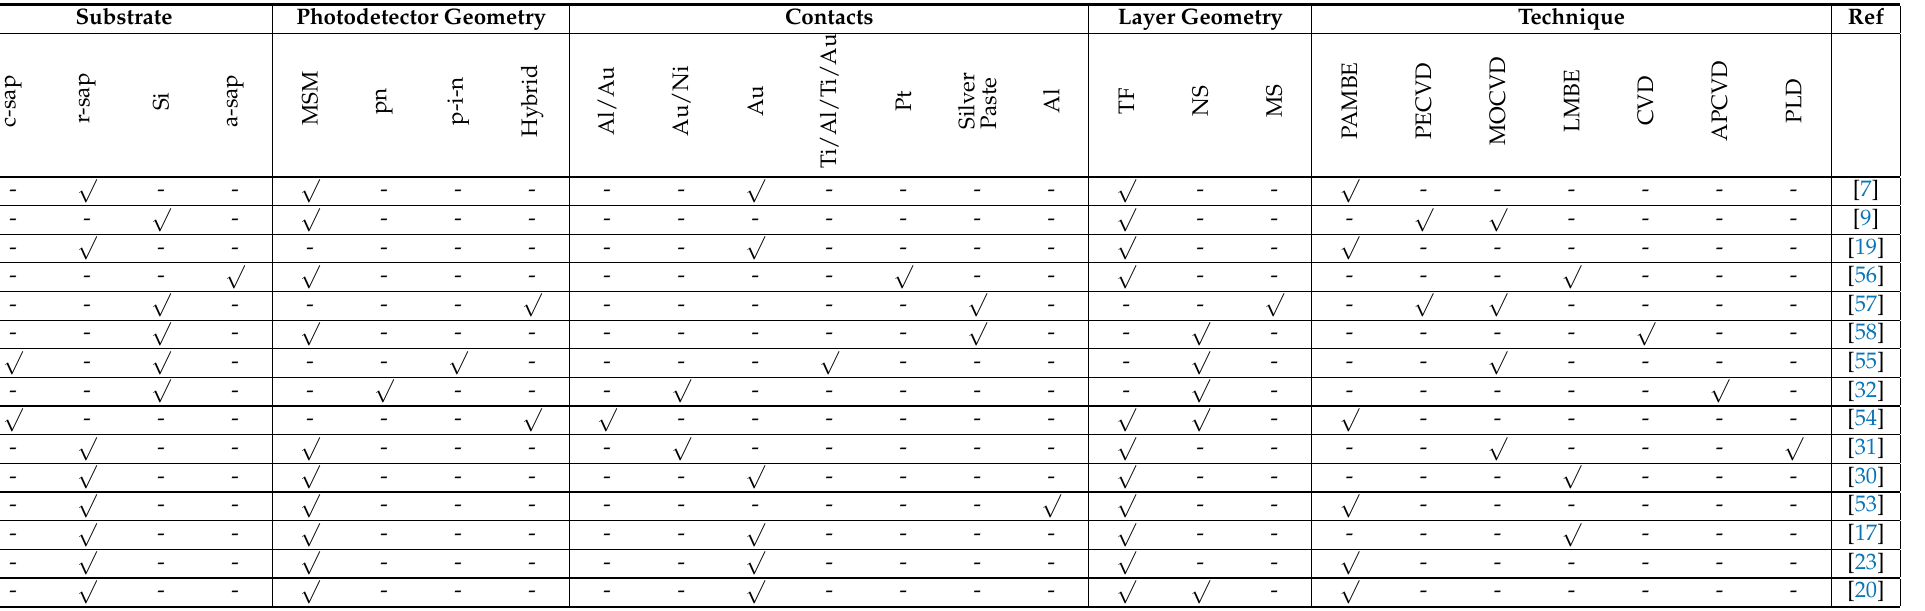
Table 1. Summary of the growth and fabrication of non-polar GaN-based